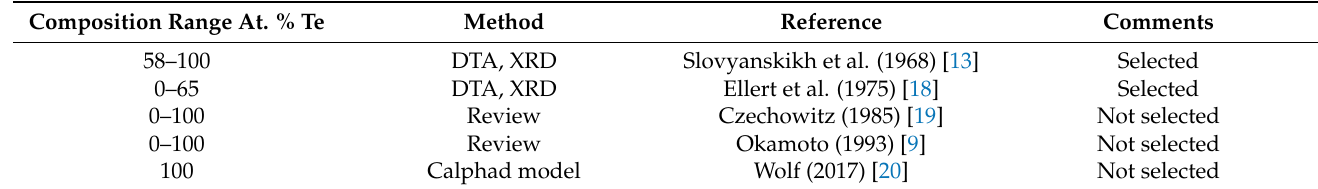
Table 2. Phase diagram data on the U–Te